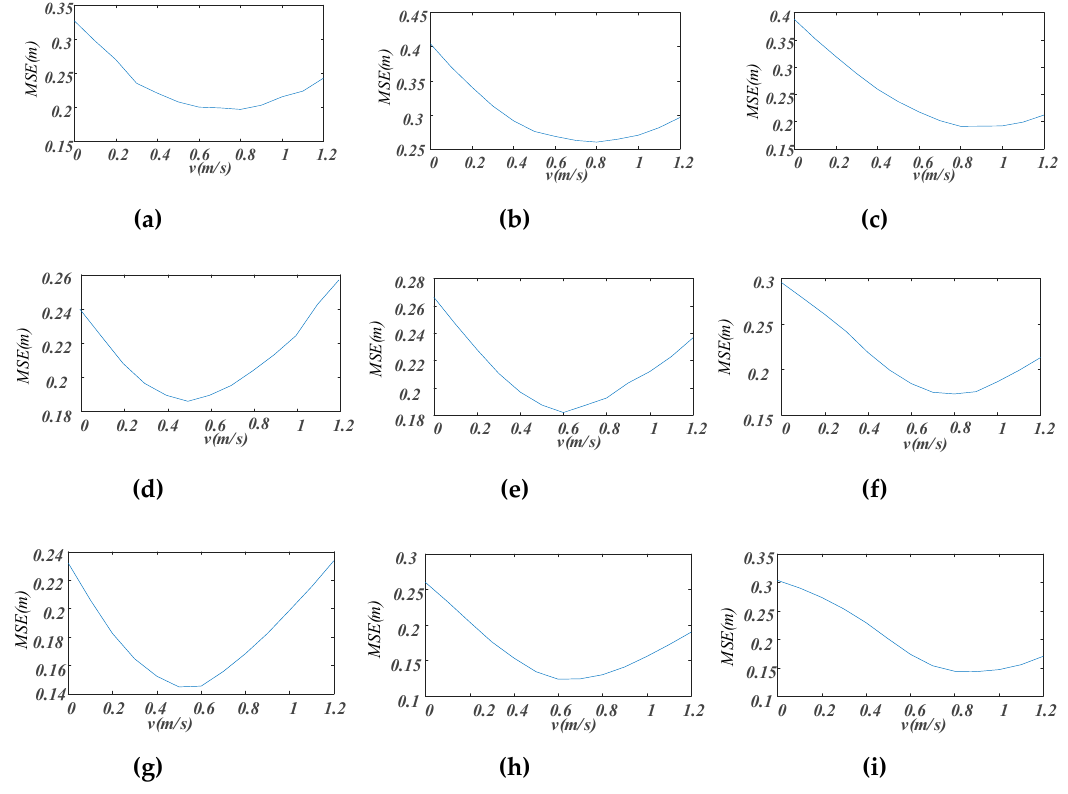
Figure 14. Relationship between positioning mean squared error (MSE) and v values. ( a ) Track 1 slow-speed; ( b ) Track 1 medium-speed; ( c ) Track 1 high-speed; ( d ) Track 2 slow-speed; ( e ) Track 2 medium-speed; ( f ) Track 2 high-speed; ( g ) Track 3 slow-speed; ( h ) Track 3 medium-speed; ( i ) Track 3 high-speed. Table 3. The percentage (%) of the abnormal positioning with errors greater than 50 cm. Track 1 (before / after) Track 2 (before / after) Track 3 (before / after) Slow-speed 15.20 / 7.35